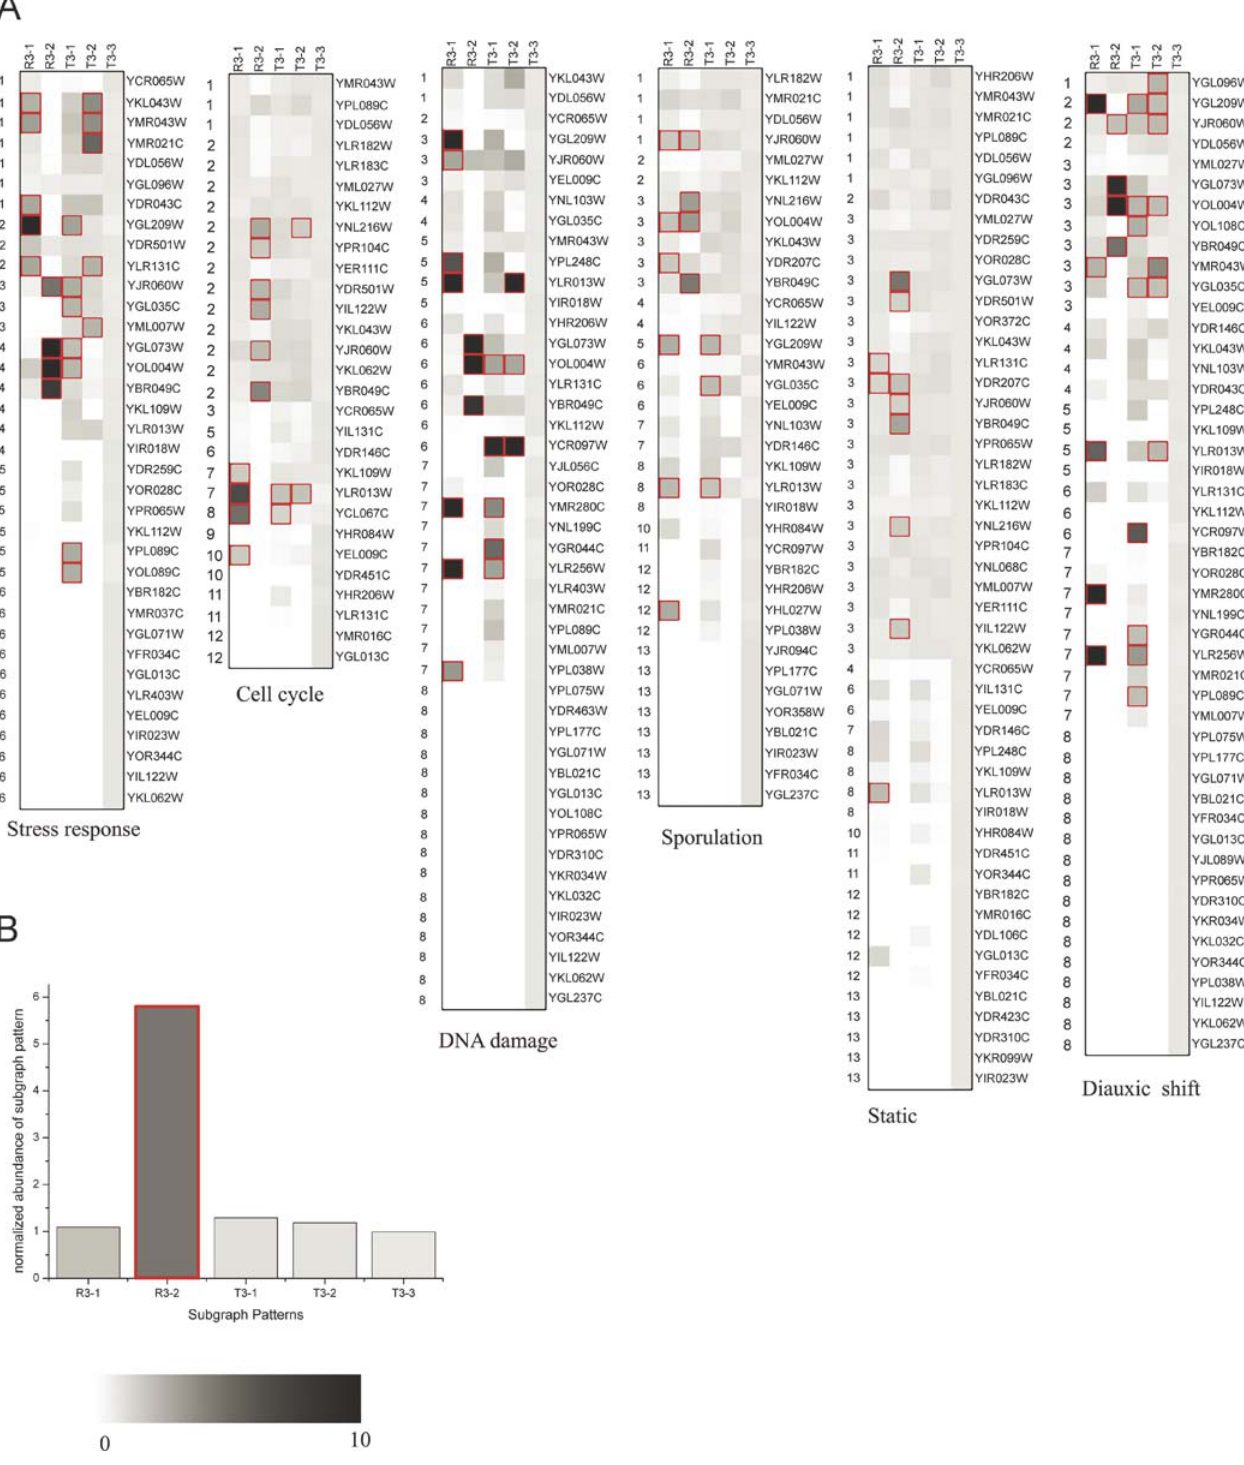
Figure 2. SPP and SPL (A) THub SPLs at the 3-vertex level of the yeast static transcriptional regulatory network and the five condition-specific sub-networks. The THub SPPs (rows) are ordered according to the hierarchical structure of each network. The layer numbers are given to the left of each row. The normalized abundances (A N ) of the regulatory subgraph patterns are represented as shades of grey (black means A N (cid:1) 10 ); squares with red borders indicating the significantly preferred patterns. The corresponding figure for the 4-vertex level SPLs can be found in Protocol S1. (B) Three-vertex SPP of the THub YGL073W. DOI: 10.1371/journal.pcbi.0020047.g002